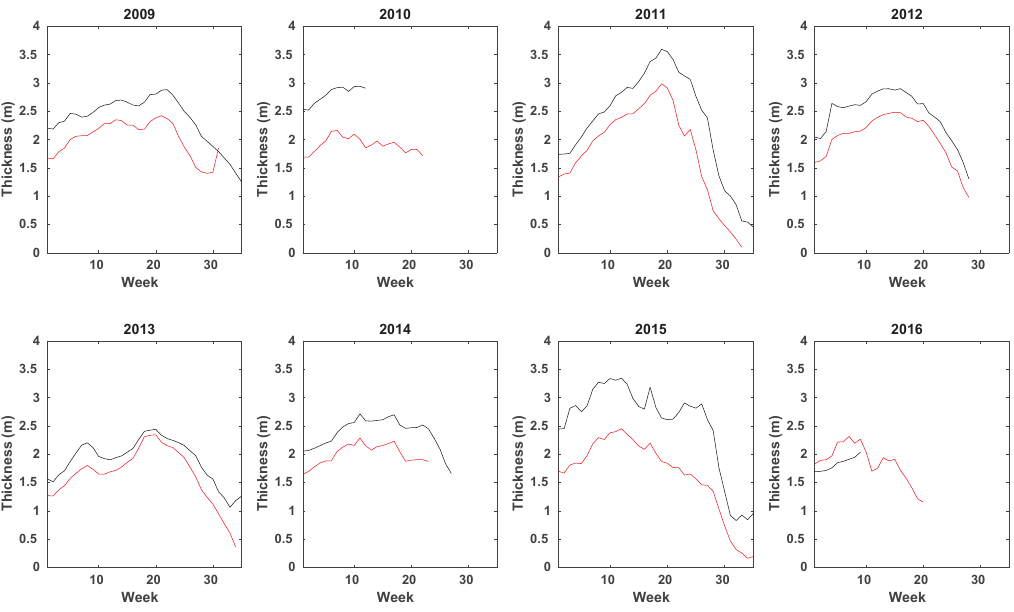
Figure 6. PIOMAS model ice thickness of melted ( red ) and surviving ( black ) sea ice parcels during